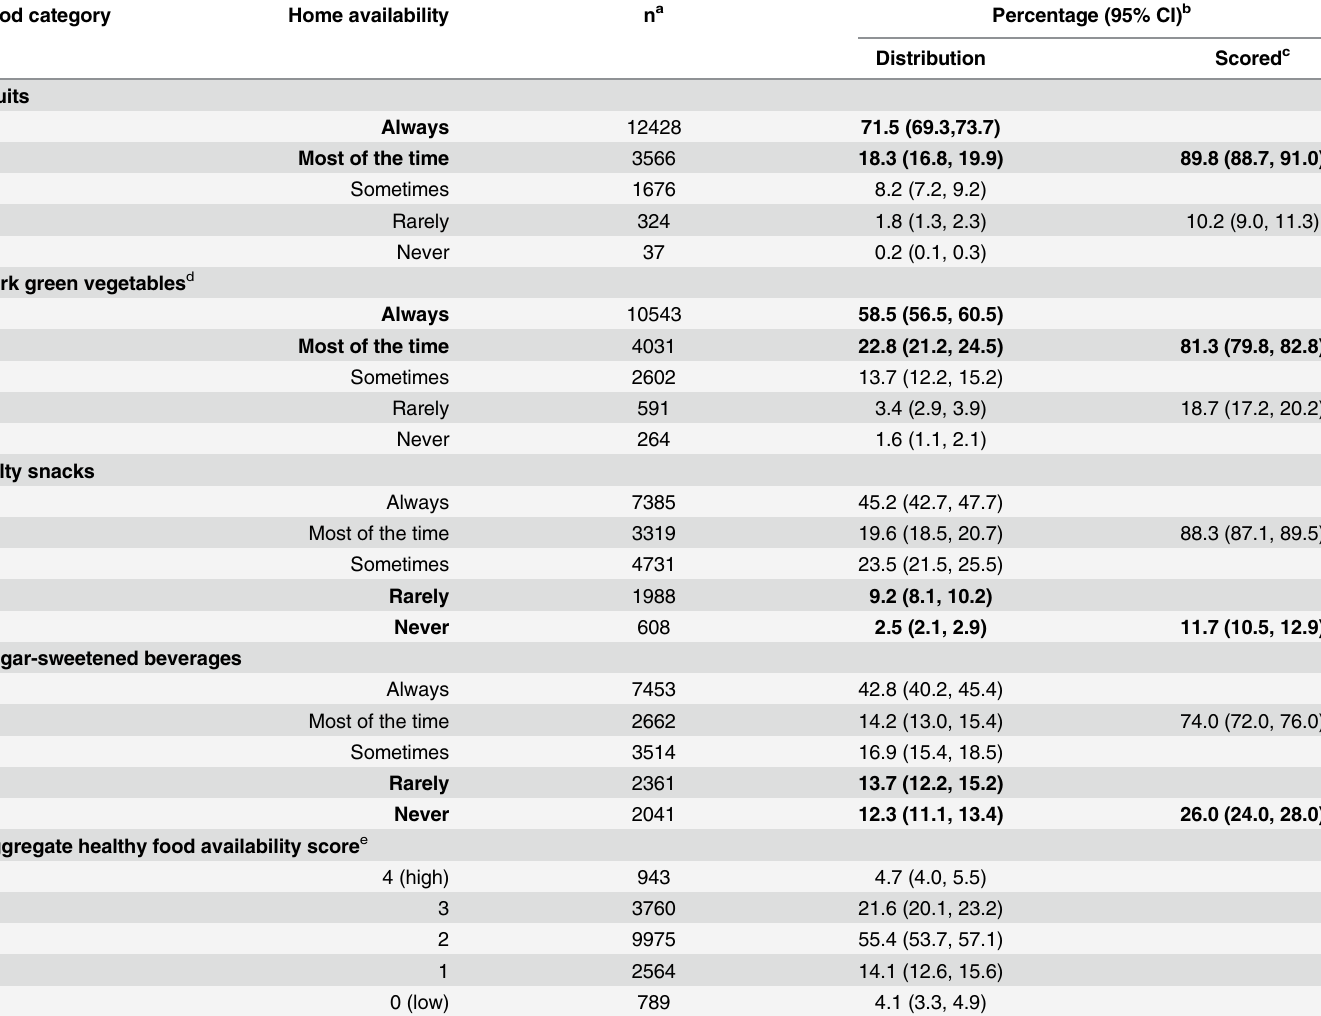
Table 2. Home availability of fruits, dark green vegetables, salty snacks, and sugar-sweetened beverages for U.S. multi-person households: NHANES 2007 – 10. Food category